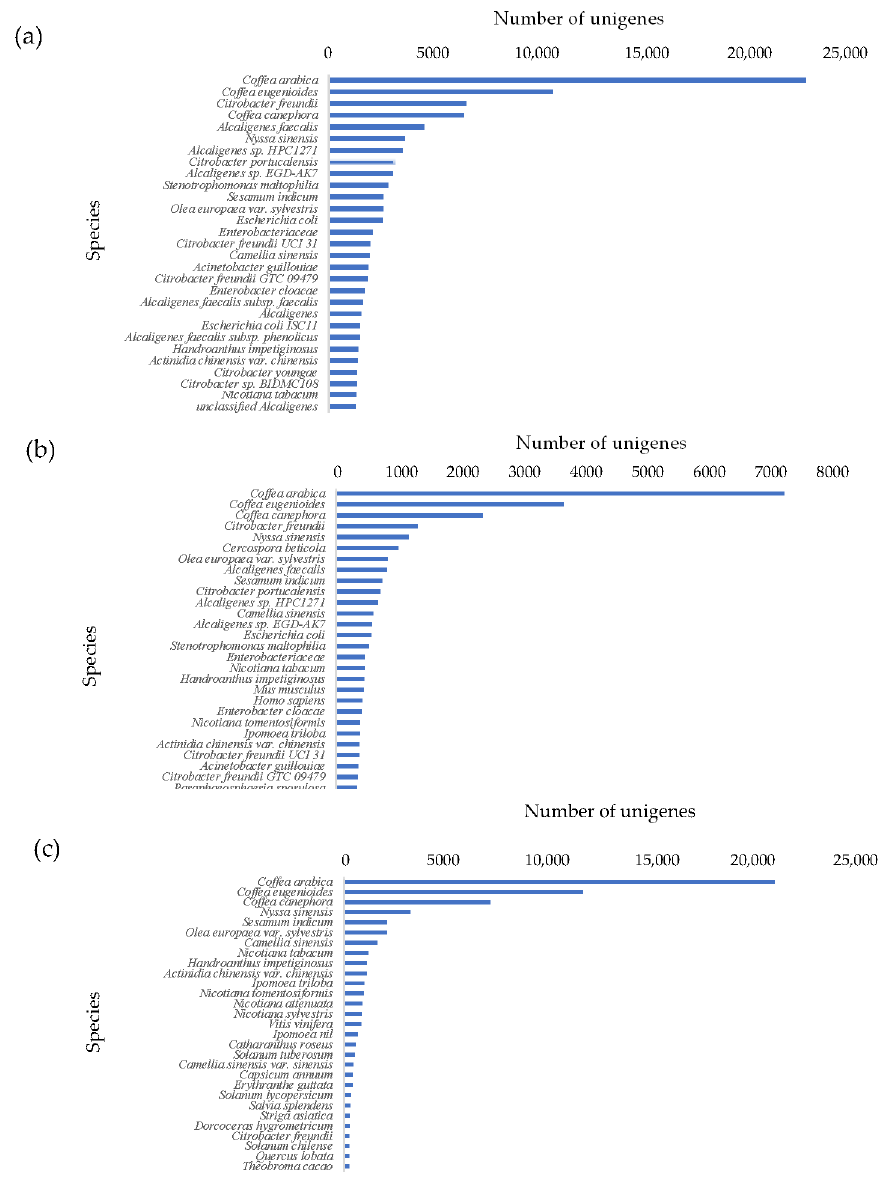
Figure 3. The homological species distribution annotation of ( a ) H. cagayanensis; ( b ) H. lacunosa; and ( c ) H. coriacea unigenes against the NCBI-NR database.